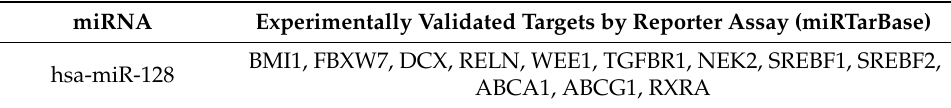
Table 3. Predicted target genes for miR-128 identified by miRTarBase.